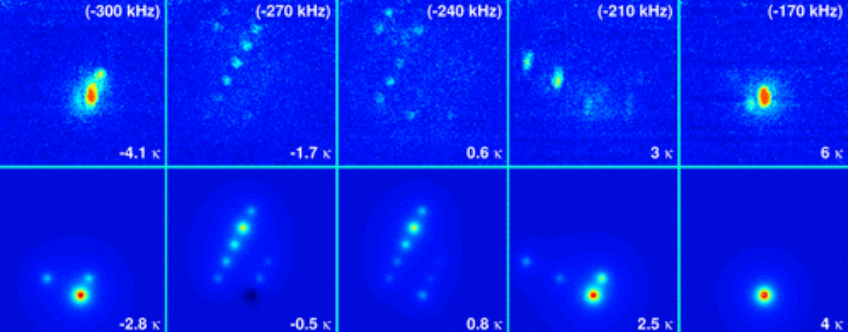
Figure 14. Momentum distributions of N = 80,000 atoms observed with different pump laser detunings ∆ c (in brackets) after a τ = 200 µ s pump laser pulse. The upper row corresponds to ∆ 2 , the lower row shows simulated momentum distributions. a = − 2 π × 4.7 GHz and I = 50 mW/cm Reprinted with permission from ref. [58]. Copyright 2011 American Physical